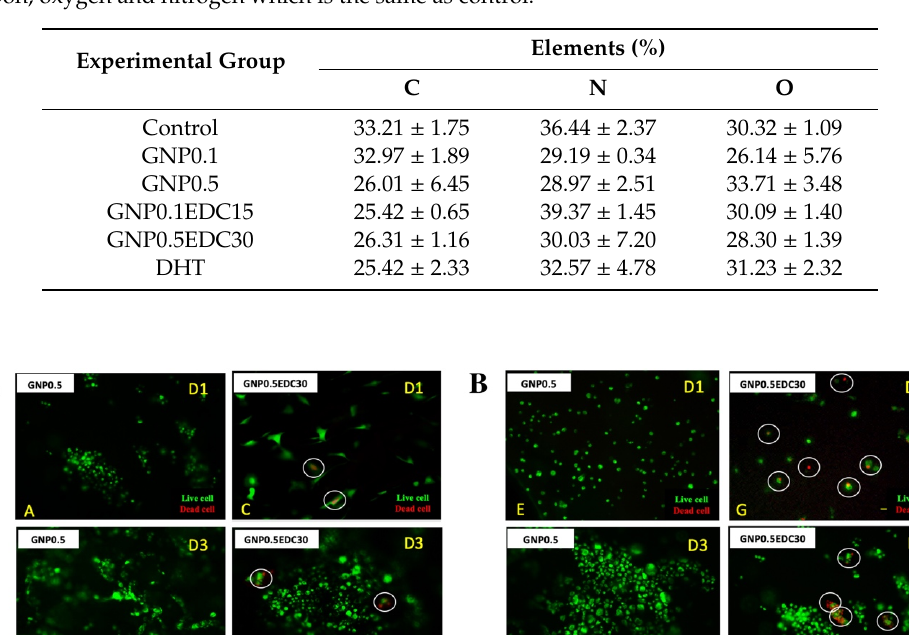
Table 2. Elemental analysis by EDS. All sca ff olds showed the presence of various elements such as carbon, oxygen and nitrogen which is the same as control.